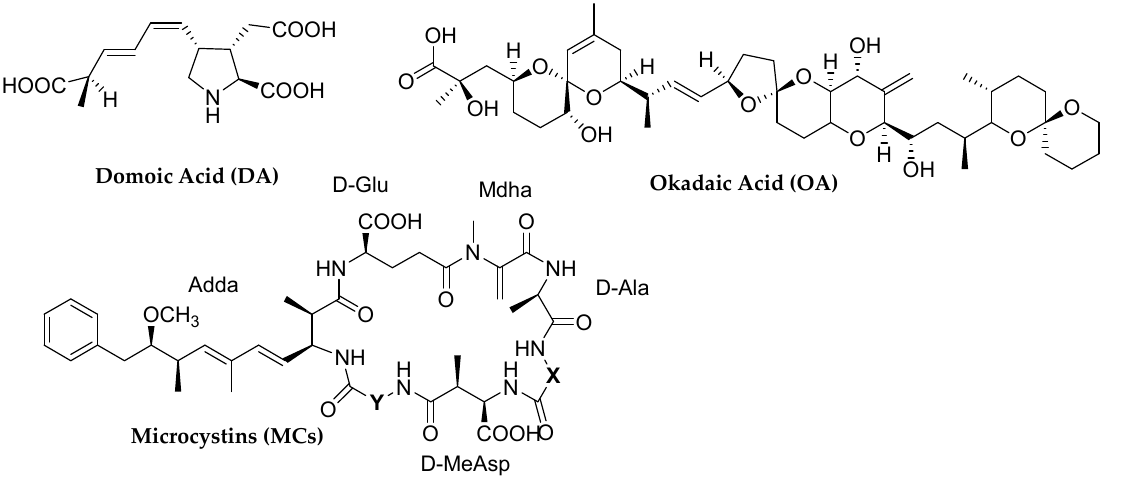
Figure 1. Molecular structures of the target phycotoxins and cyanotoxins.